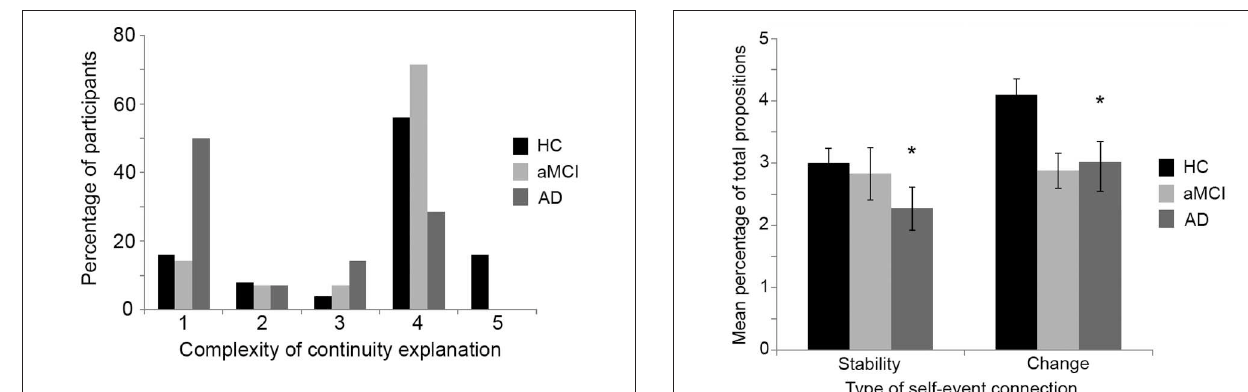
FIGURE 3 | Percentage of participants from each group providing each level of sophistication of response on the persistence explanation. HC, Healthy control; aMCI, amnestic Mild Cognitive Impairment; AD, Alzheimer’s disease. Scores of 1 represent the lowest level of sophistication, while scores of 5 indicate the highest level of sophistication.